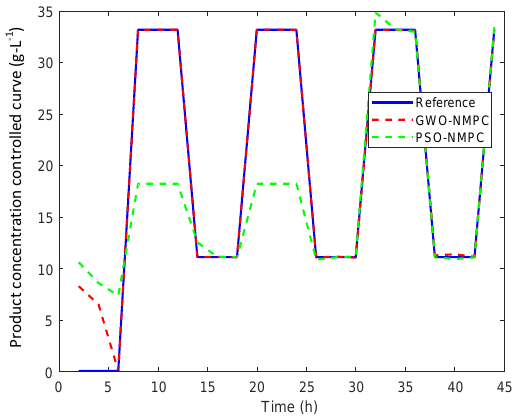
Figure 5. GWO-NMPC controlled product concentration output with hypothetical reference.